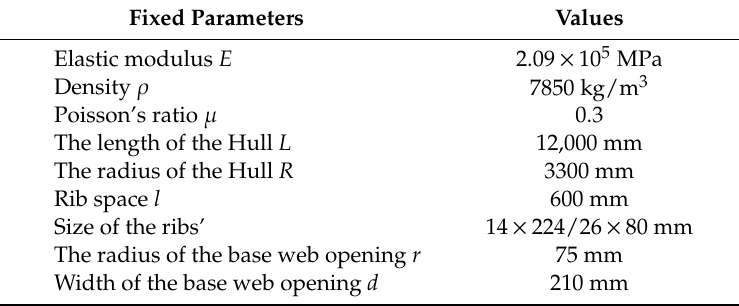
Figure 6. The structural profile of the base. Table 7. The values of the fixed structural and material parameters.